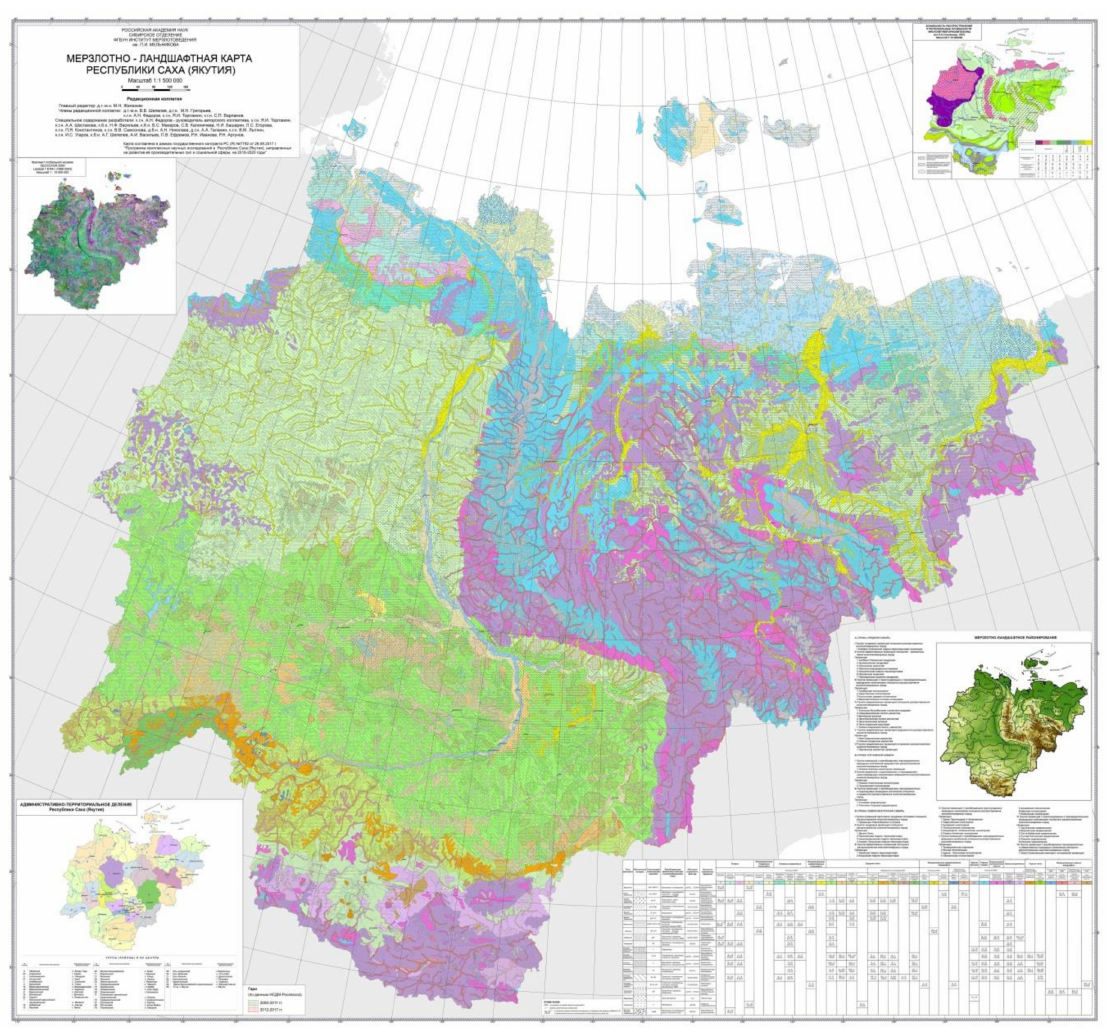
Figure 1. Permafrost-landscape map of the Republic of Sakha (Yakutia) on a scale of